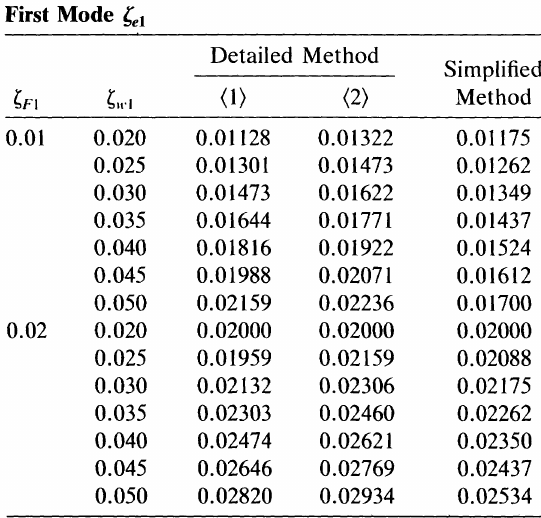
Table 1. Equivalent Modal Damping Ratios